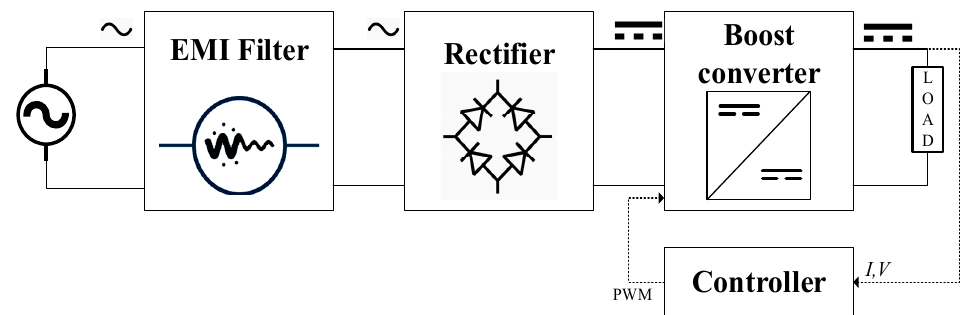
Figure 1. Block diagram of the boost PFC that includes an EMI filter.